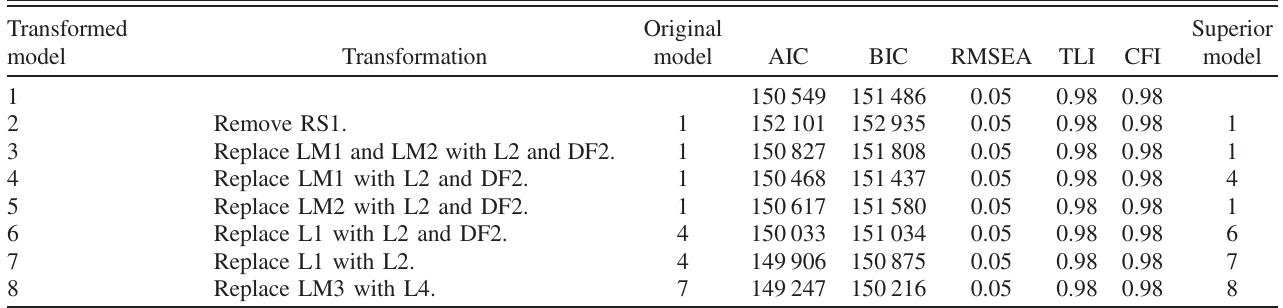
TABLE V. The MIRT model transformation